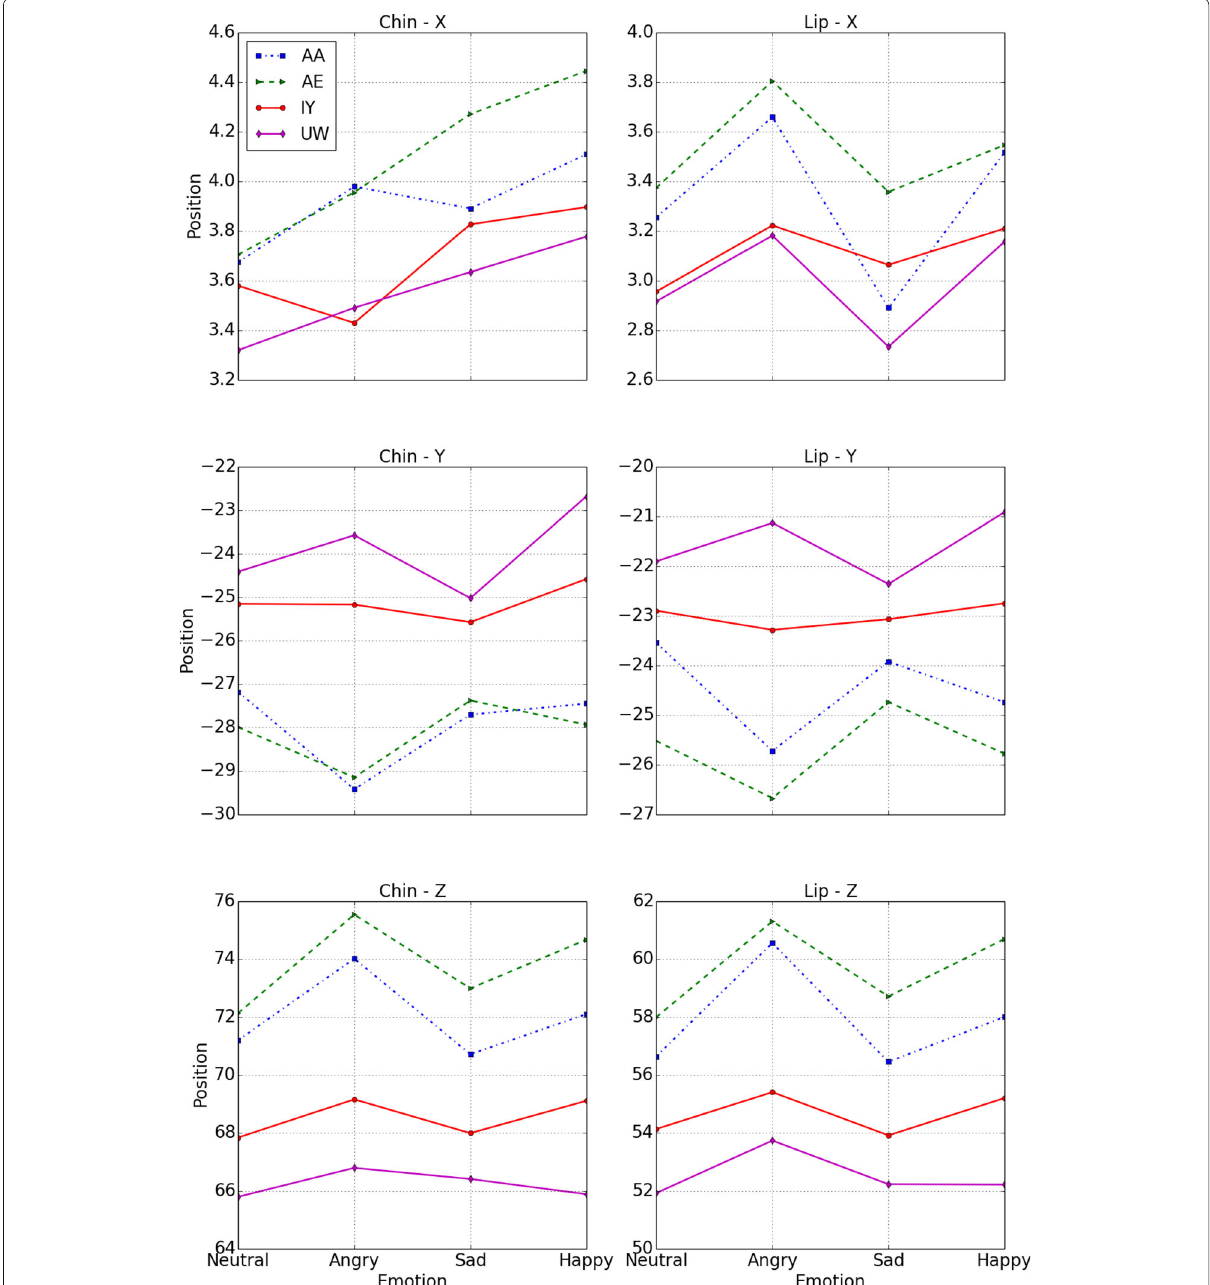
Fig. 4 Mean position of select articulatory targets, averaged across all speakers, for different vowels and emotions in the USC IEMOCAP database. (Top row) X , (middle row) Y , and (bottom row) Z